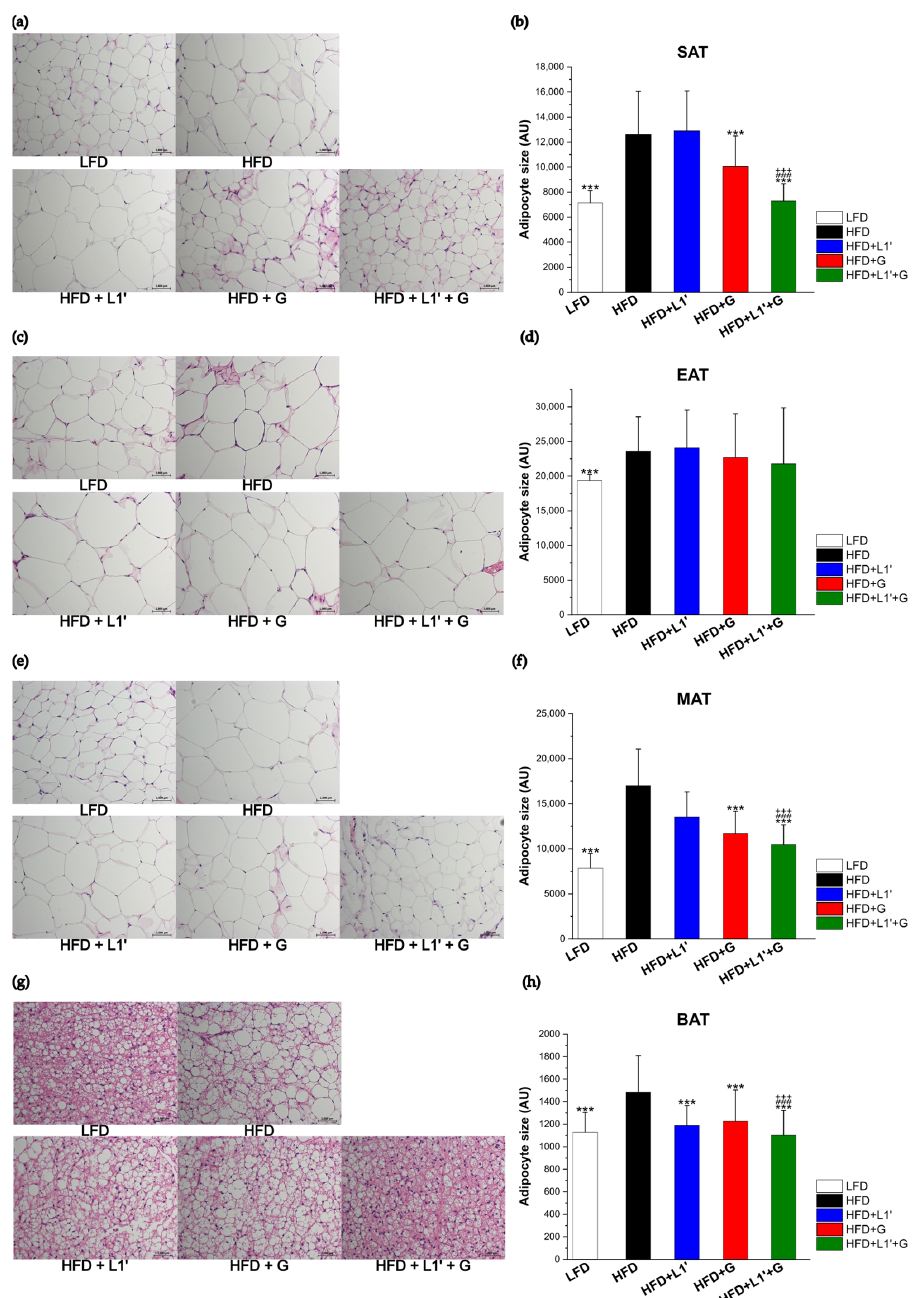
Figure 3. Combining L. plantarum HAC03 and G. cambogia has a synergic effect on decreasing the adipocyte size. ( a , c , e , g ) Histological features of adipose tissue between groups. Representative photomicrographs of adipose tissue sections stained with hematoxylin and eosin (×200) are shown. Subcutaneous adipose tissue (SAT), epididymal adipose tissue (EAT), mesenteric adipose tissue (MAT), and brown adipose tissue (BAT). ( b , d , f , h ) Adipocyte size of adipose tissue between groups. The data are presented as mean ± SD ( n = 8). A one-way ANOVA with Dunnett’s comparison test was used for comparison with HFD groups. *** p < 0.001. A Student’s two-tailed t -test was used for analysis of difference between experimental groups. ### p < 0.001 between HFD + G group and HFD + L1 ′ + G group. +++ p < 0.001 between HFD + L1 ′ group and HFD + L1 ′ + G group.